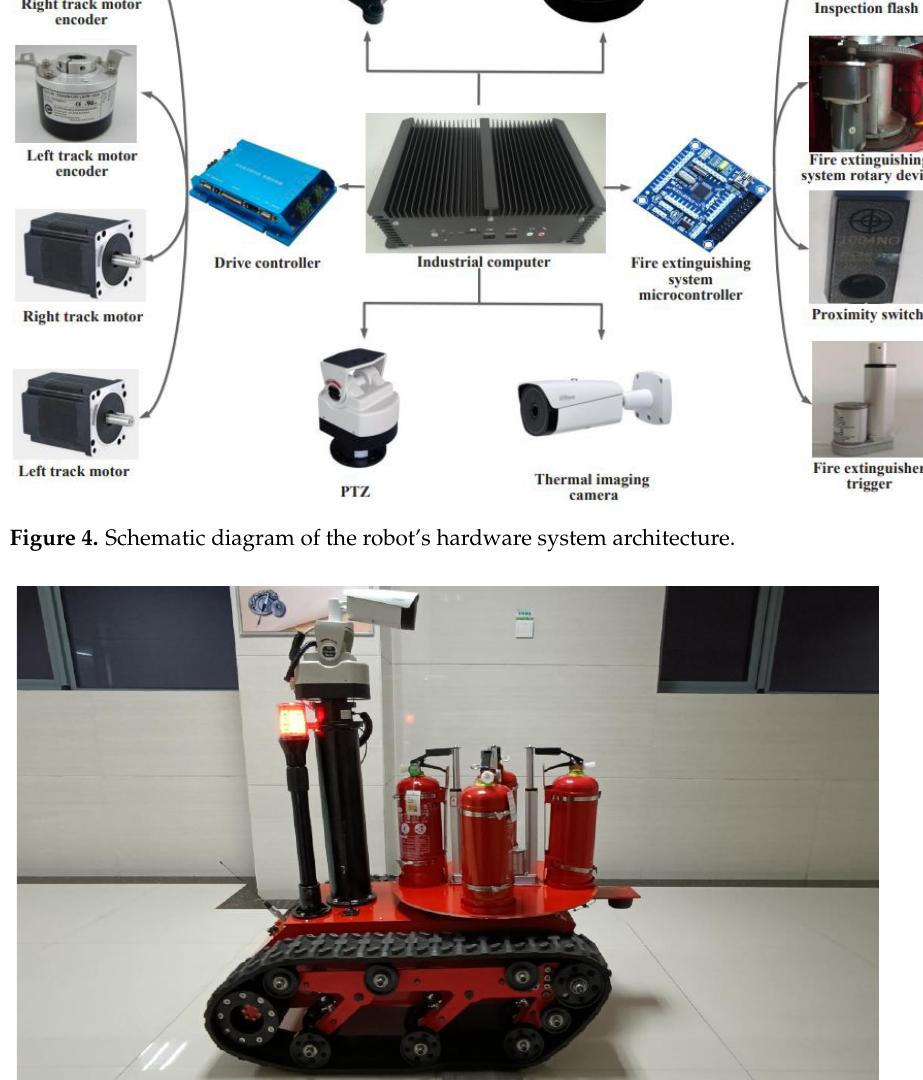
Figure 4. Schematic diagram of the robot ’s hardware system architecture.